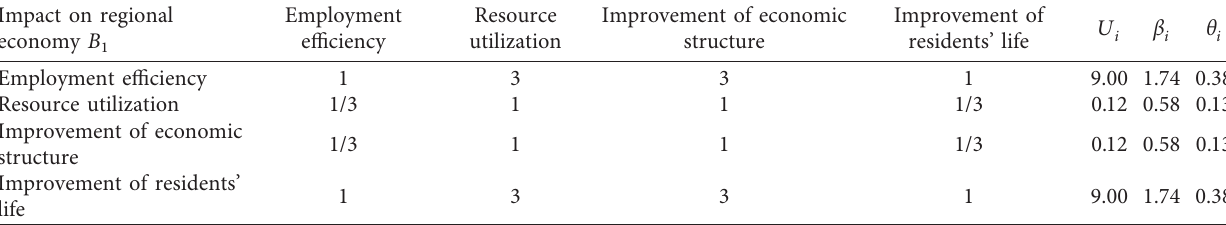
Table 5: Weight of all levels of indicators in the evaluation index system.